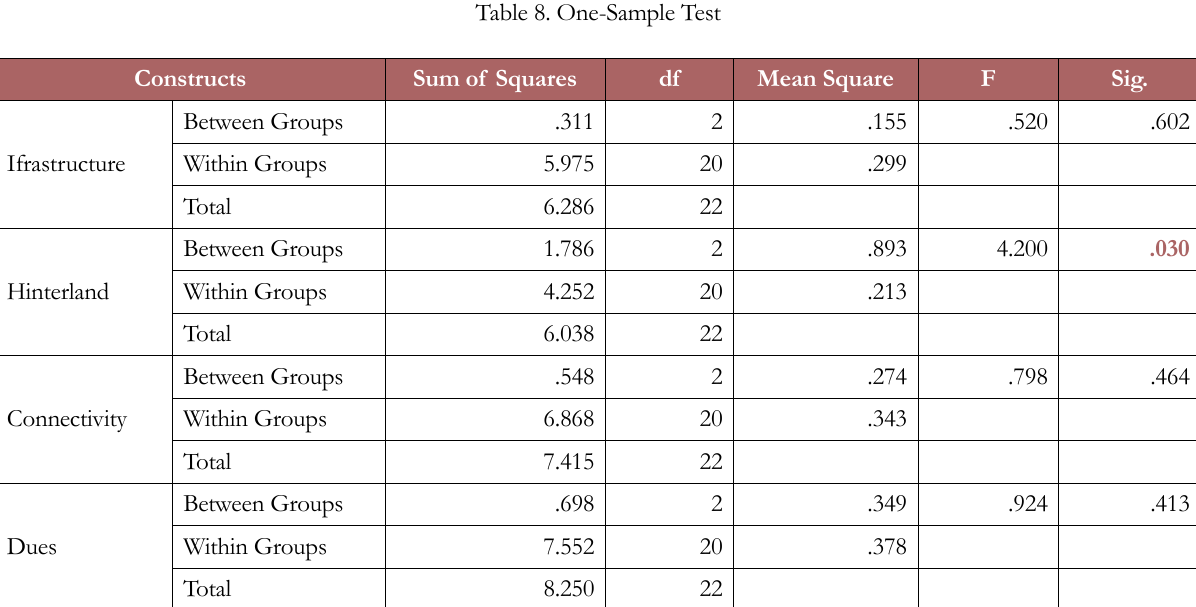
Table 9. Analysis of Variance (ANOVA) for Shipping Lines Companies (Feeder & Deep